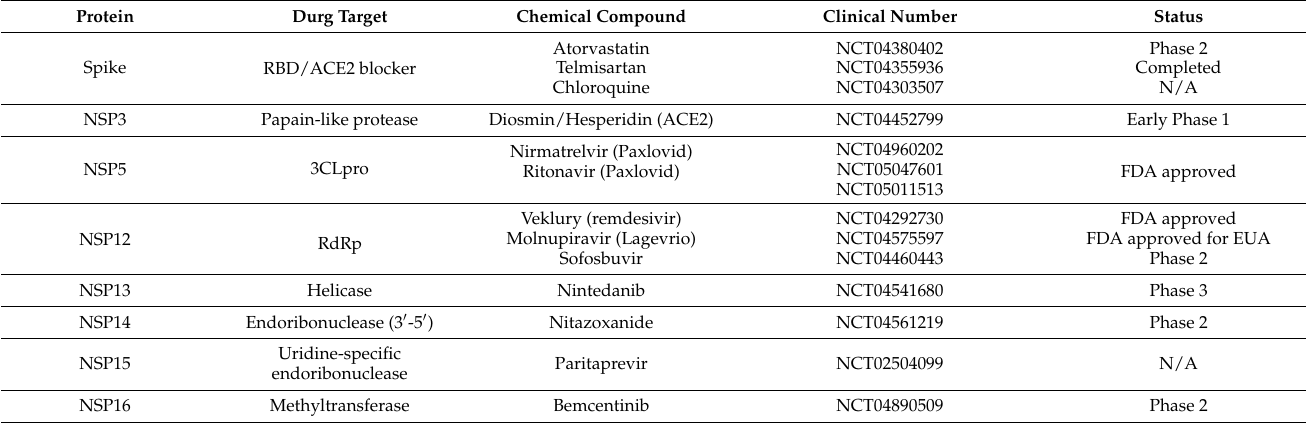
Table 1. Chemical compounds targeting spike protein and nonstructural proteins for SARS-CoV-2 in clinical studies.